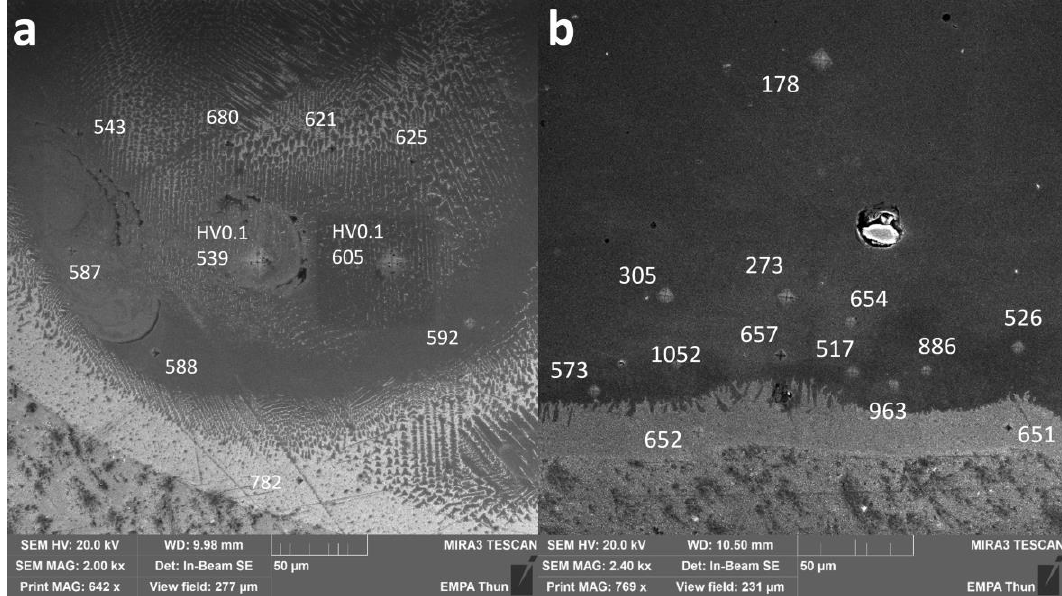
Figure 8. SEM images of cross-sections of ( a ) Line_P_5 and ( b ) Wall_NL_5. Numbers without specification are HV 0.01 values. Two points were measured as HV 0.1 to compare with results from multiple grains covered.